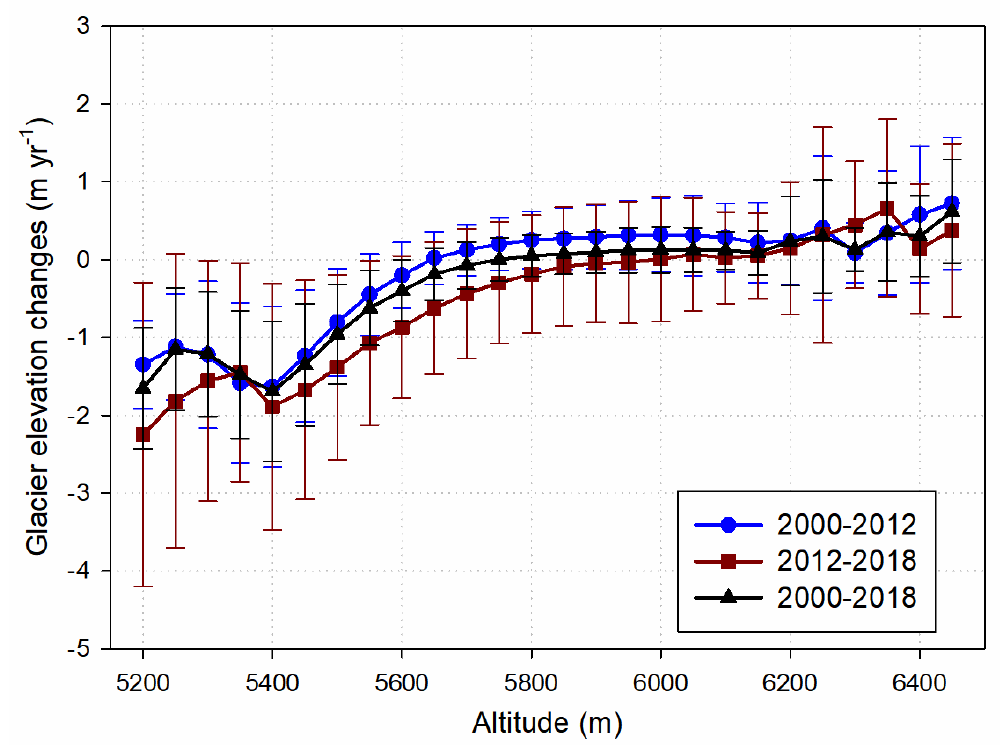
Figure 3. The annual rate of glacier elevation changes versus altitude over the GLDDM for the periods of 2000–2012, 2012–218 and 2000–2018. The error bars indicate the standard deviation of the observed glacier elevation